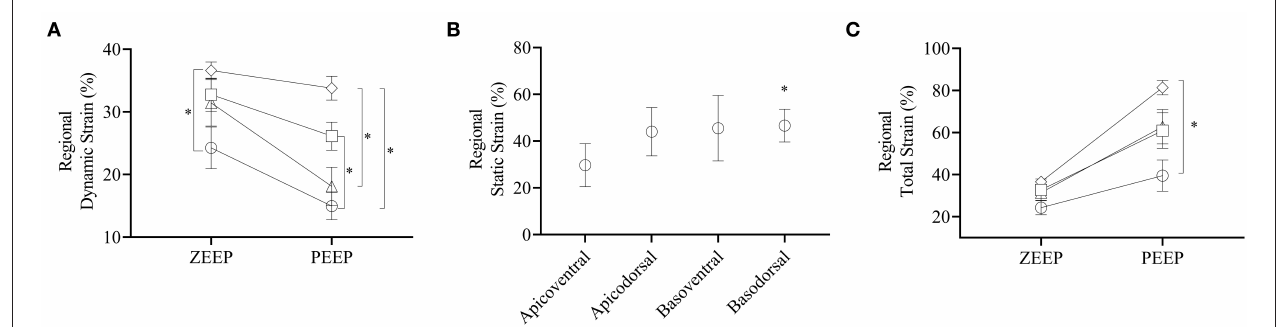
FIGURE 6 | Dynamic, static, and total strains per quadrant. (A) Dynamic strains during ZEEP and PEEP per quadrant. Open circle: apicoventral, open square: apicodorsal, open triangle: basoventral, open diamond: basodorsal. (B) Static strain induced by PEEP on each quadrant, (C) total strain induced by ZEEP and PEEP for each quadrant. Note that during ZEEP total strain is the same as the dynamic strain reported in (A) . * p <